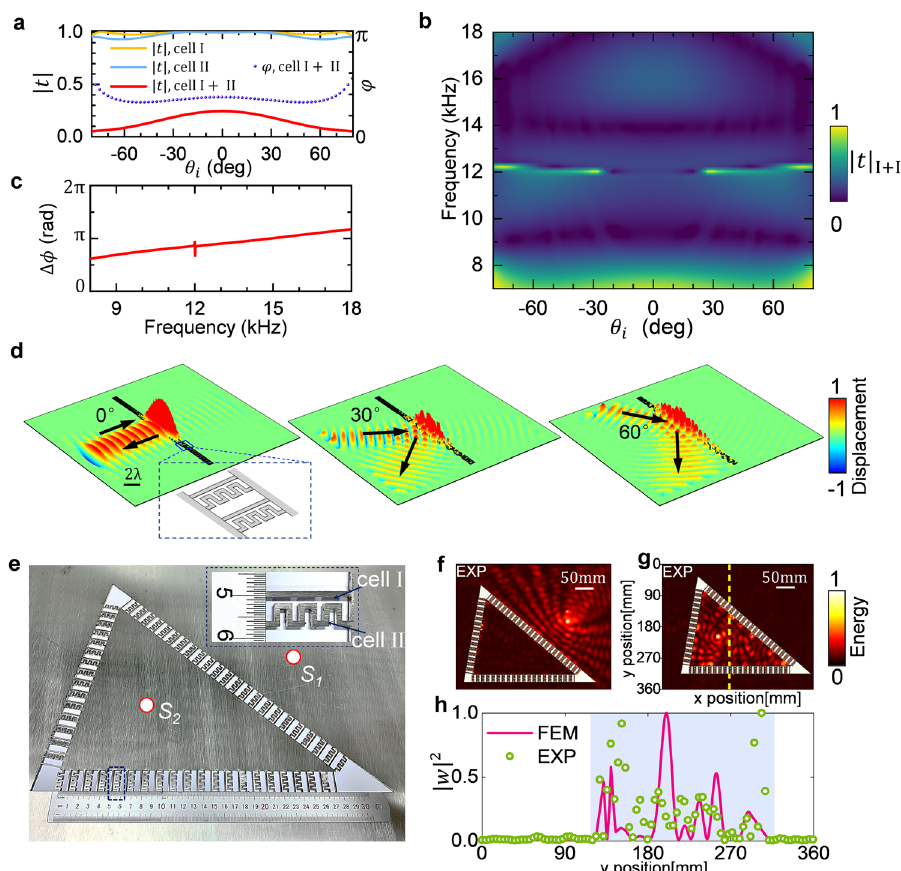
Fig. 2 Omnidirectional re fl ection of the metagrating. a Simulated transmittance | t | and re fl ection phase φ at 15 kHz as a function of the incident angle θ i . b Simulated transmittance | t | of the supercell composed by cell Ι and cell ΙΙ as functions of θ i and the operating frequency f . c Simulated phase difference Δ ϕ ¼ ϕ (cid:1) ϕ of the two unit-cells as a function of f . d Nearly total re fl ections are numerically observed for incident angels of 0°,30°,60°, respectively. I II Theoretical loci are plotted as black arrows. e Sample of a triangle-shaped omnidirectional isolator enclosed by the proposed metagratings. f Experimentally measured (EXP) energy fi eld when a point source S 1 is placed outside the enclosed region. g The measured (EXP) energy fi eld when a point source S 2 is located inside the enclosed region. h Experimental (EXP) and simulated (FEM) distributions of normalized energy (equivalent to the square of the displacement amplitude | w | 2 ) along the dashed yellow line in ( g